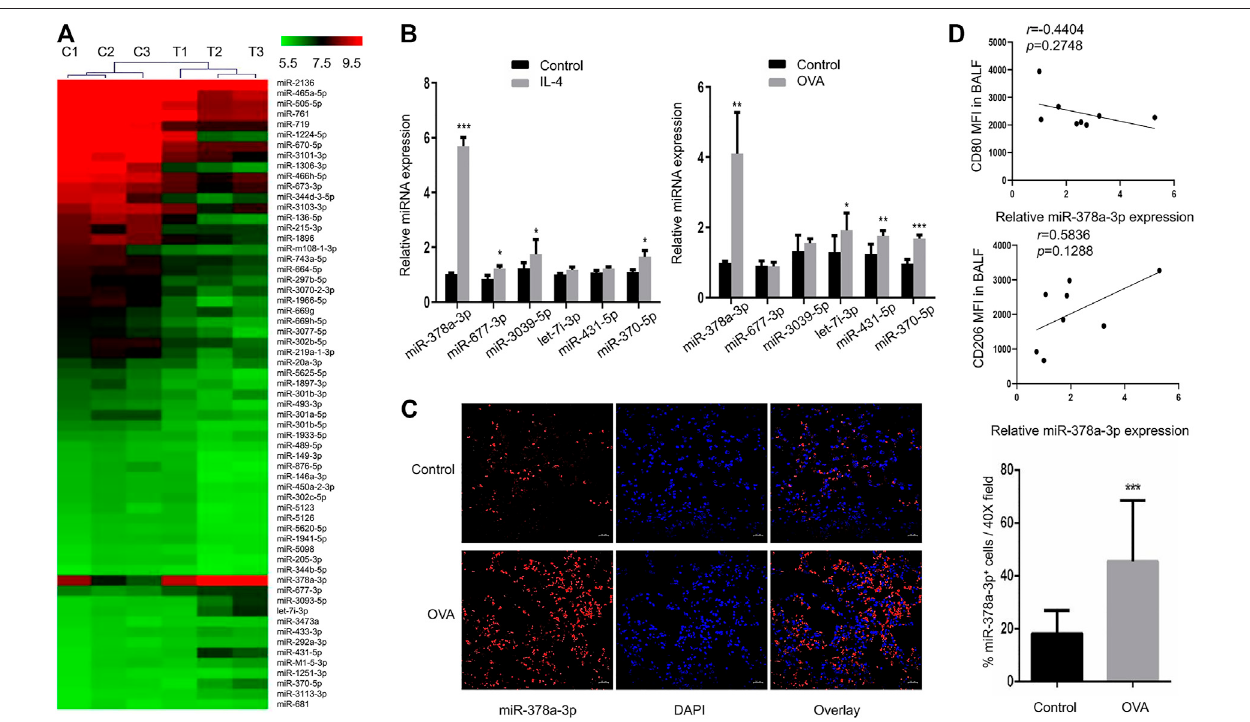
FIGURE 4 | MiR-378a-3p is upregulated in IL-4-induced M2 macrophages (A) . Differential expression levels of miRNAs (fold changes ≥ 2 and p -value < 0.05) in MH-Scellstreatedwithorwithout20 ng/mlIL-4for48 hwerepresentedinaheatmap.Themean fl uorescenceintensitywascalculatedastheaverageforthreereplicates (B) . ExpressionlevelsofthecandidatemiRNAsinMH-Scellsfollowing20 ng/mlIL-4for48 htreatmentandinthelungsofcontrolandOVA-sensitizedmiceasdeterminedbyRT- qPCR (C) .RepresentativeimagesofFISHformiR-378a-3pinthelungtissuesofcontrolandOVA-sensitizedmiceasshownatamagni fi cationof40X.Scalebar:20 μ m. QuantitationofpercentageofmiR-378a-3p + cellsper 40X fi eld (D) . Scatter plotsofCD80, CD206 MFIinBALF and relative miR-378a-3pexpressionfromcontroland OVA- sensitized mice. Individual data points are shown with p value and linear regression. ( n (cid:2) 8, * p < 0.05, ** p < 0.01, *** p < 0.001 vs.